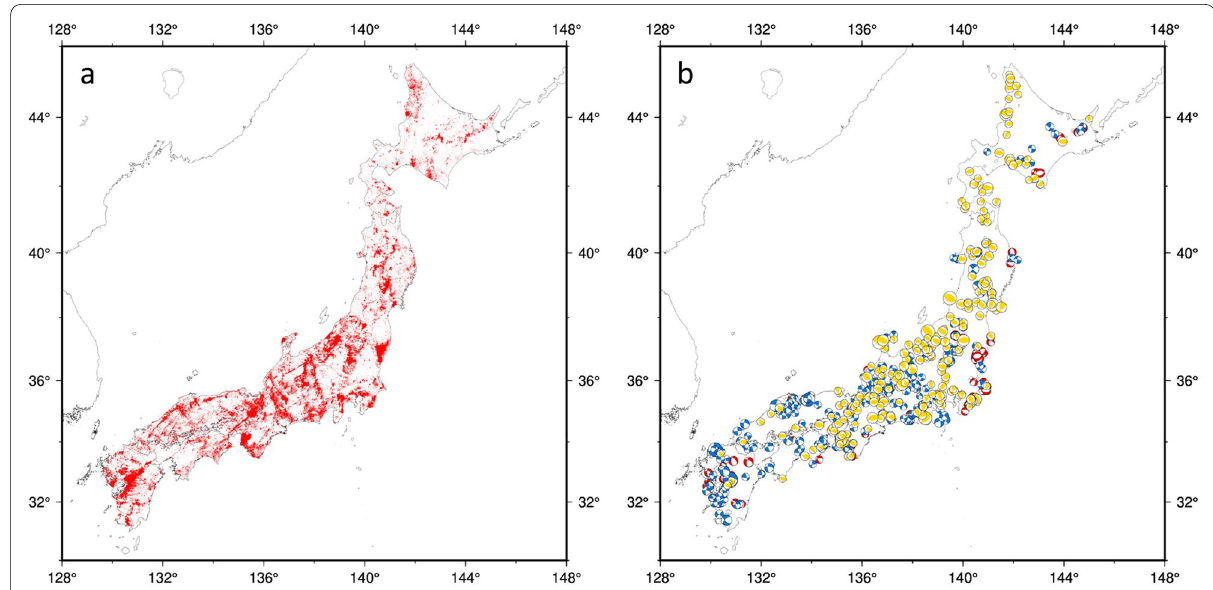
Fig. 4 a The distribution of 195,158 earthquakes in the declustered earthquake catalogue. b The distribution of mainshock focal mechanisms (F-net) used in this study. Red balls are normal faultings, blue balls are strike-slip faultings and yellow balls are reverse faultings